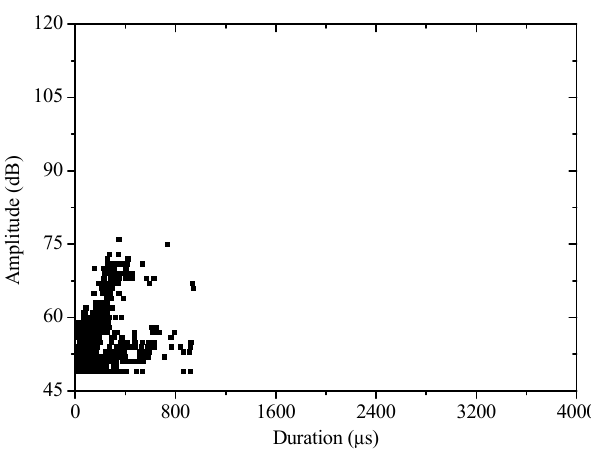
Figure 5. AE amplitude vs. duration (1.5 kg/m 3